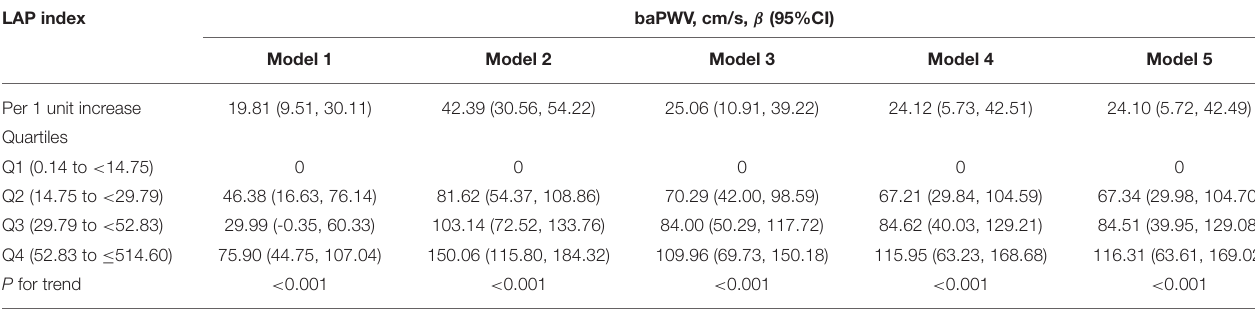
TABLE 3 | The association between LAP and brachial-ankle pulse wave velocity (baPWV) in different